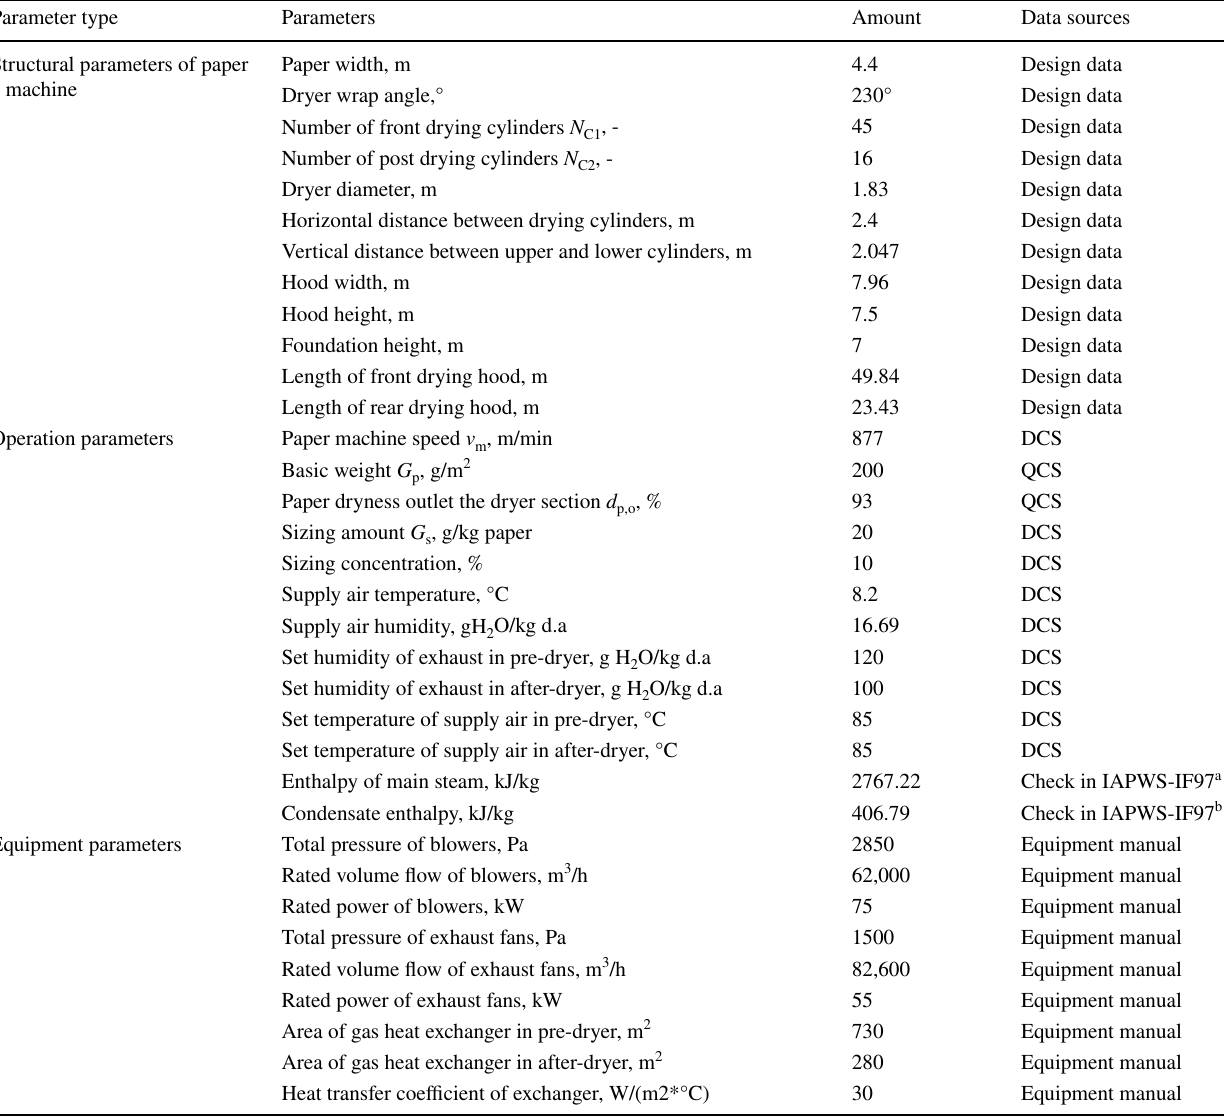
Table 1 The main operating parameters and equipment information of paper